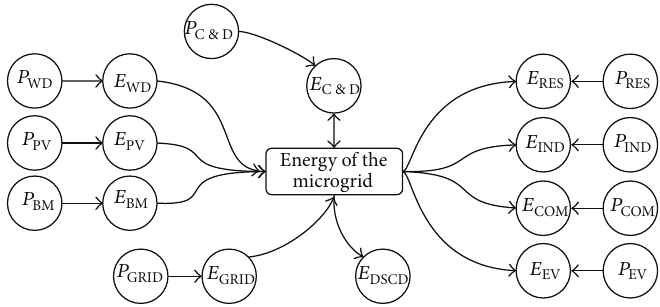
Figure 2: Logical setup of the management layer.